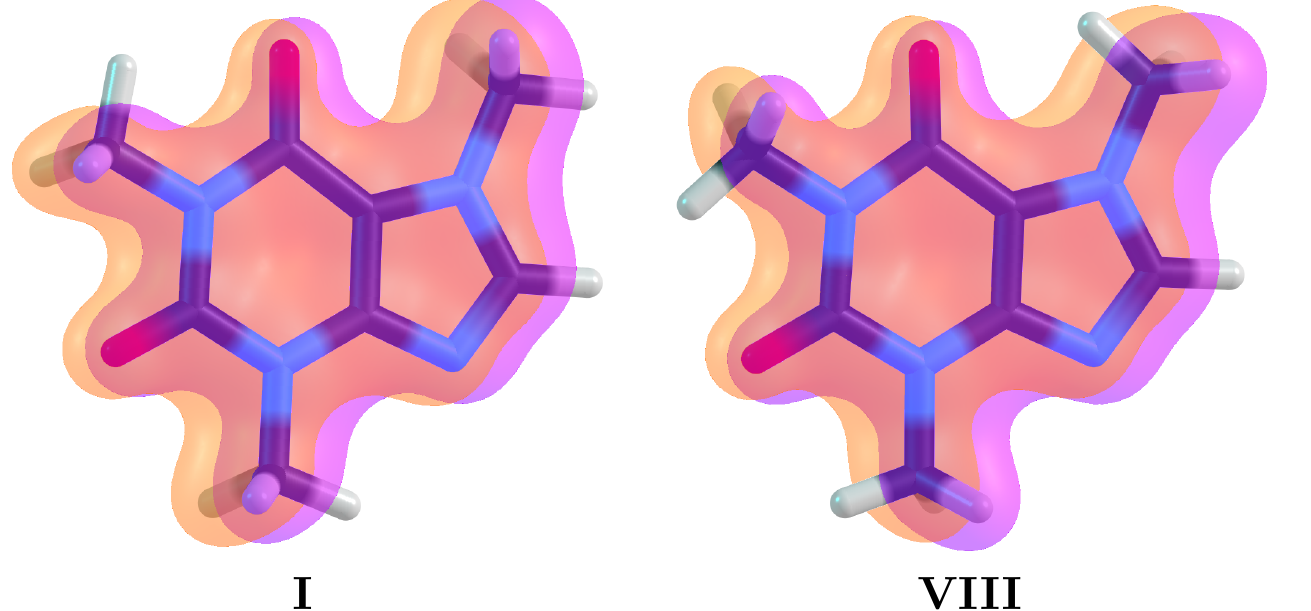
Figure 1. Extended π delocalization for the lowest ( I ) and highest ( VIII ) energy structures in caffeine. This delocalization contains a ten π − electron aromatic core from the two fused rings and contributions from the carbonyl groups. Notation: M1 is the methyl group at the top left of the pyrimidine ring, M2 is the methyl group at the bottom of the pyrimidine ring and M3 is the methyl group at the imidazole